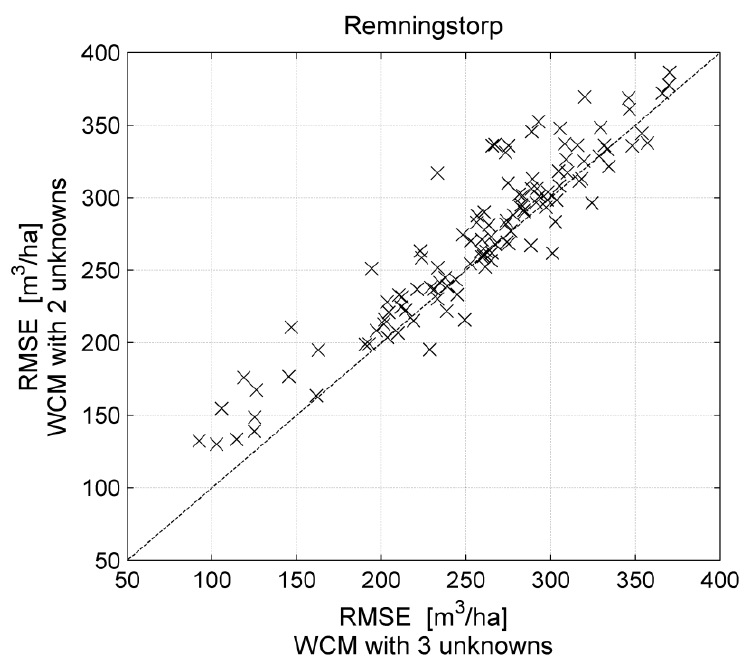
Figure 9. Scatter plot of single-image RMSEs for a model with three unknowns (horizontal axis) and a model with two unknowns where the parameter β was set a priori equal to 0.006 (vertical axis). Test site: